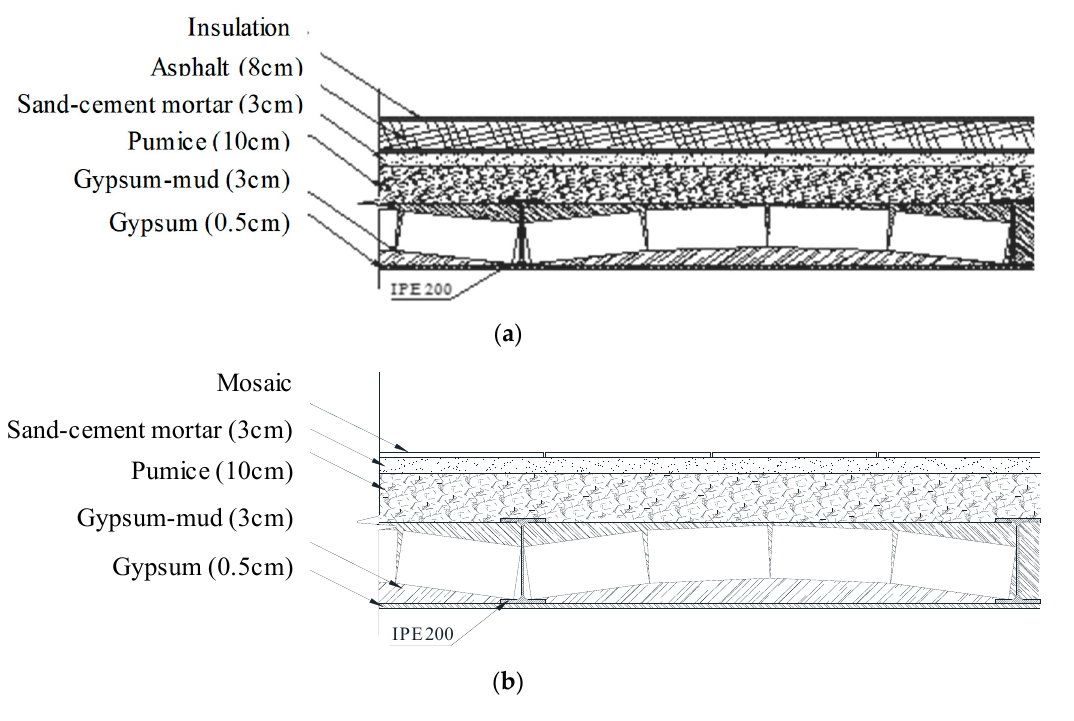
Figure 5. Details of jack-arch diaphragm system (dimensions are in cm): ( a ) Building roof; ( b ) Other stories. Table 1. Walls’ ratio in the models.